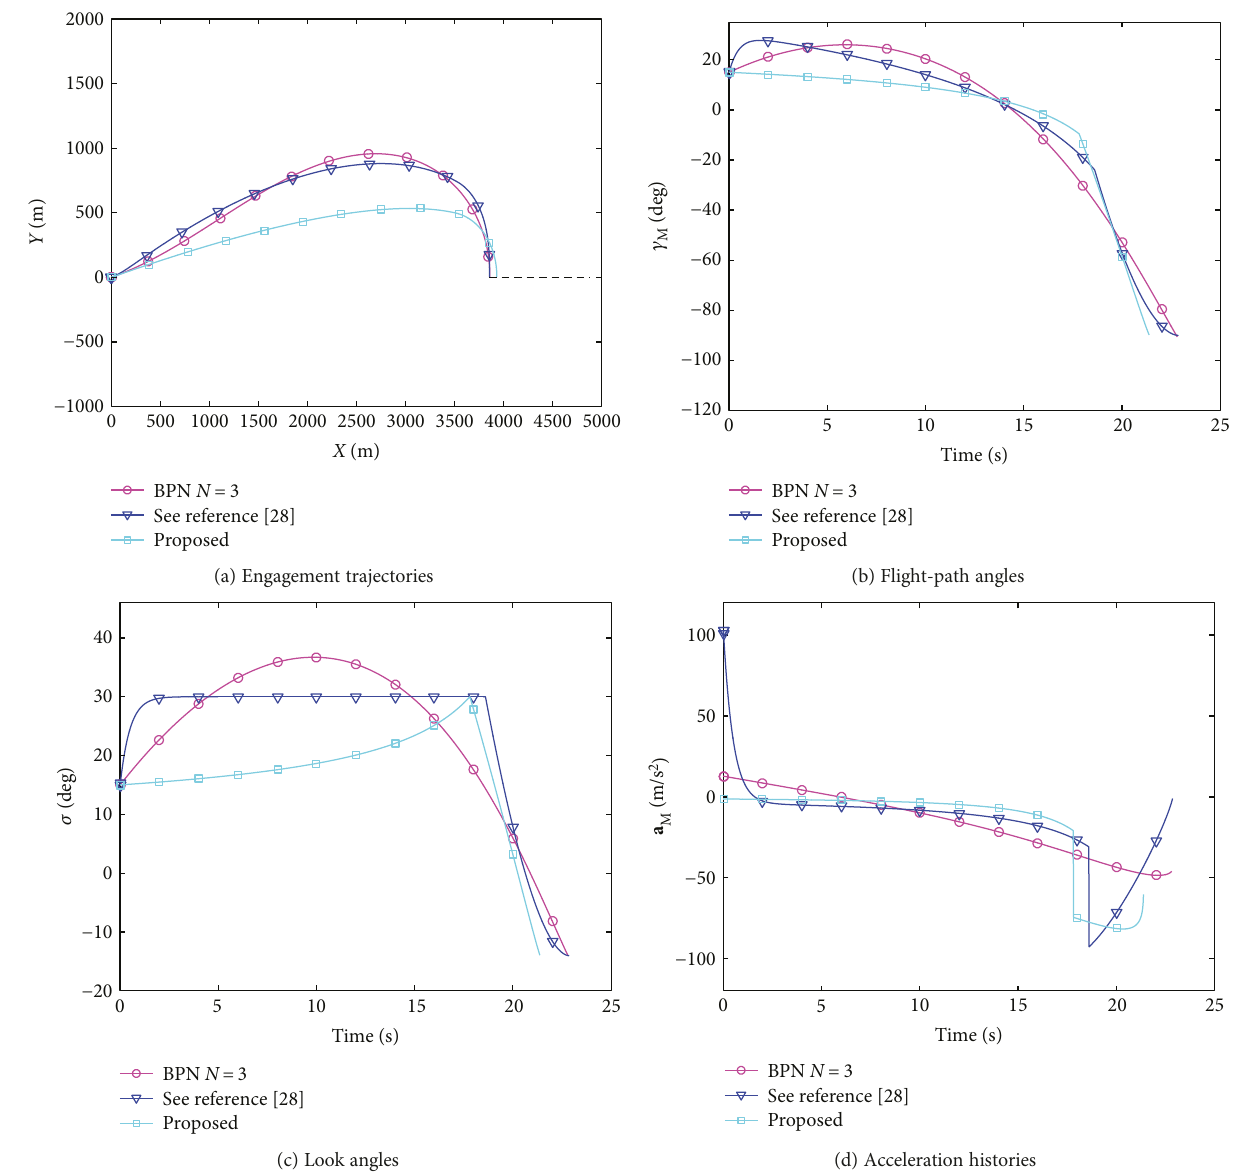
Figure 6: The results for the comparative cases with γ